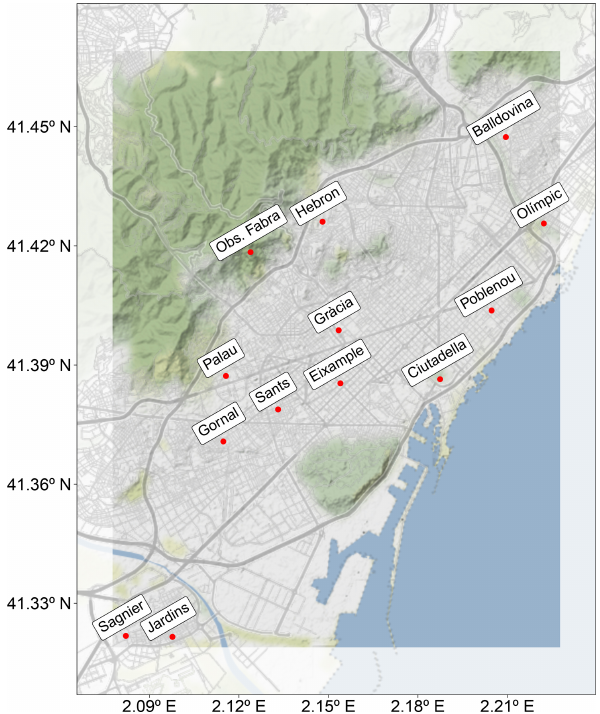
Figure 2. Domain of study and location of the referenced mon- itoring stations. The map has been generated using the ggplot2 (Wickham, 2016) and ggmap (Kahle and Wickham, 2013) R pack- ages (R Core Team, 2013) and data from OpenStreetMap. © Open- StreetMap contributors 2017, distributed under the Open Data Com- mons Open Database License (ODbL) v1.0. Map tiles are by © Sta- men Design, under a Creative Commons Attribution (CC BY 3.0)